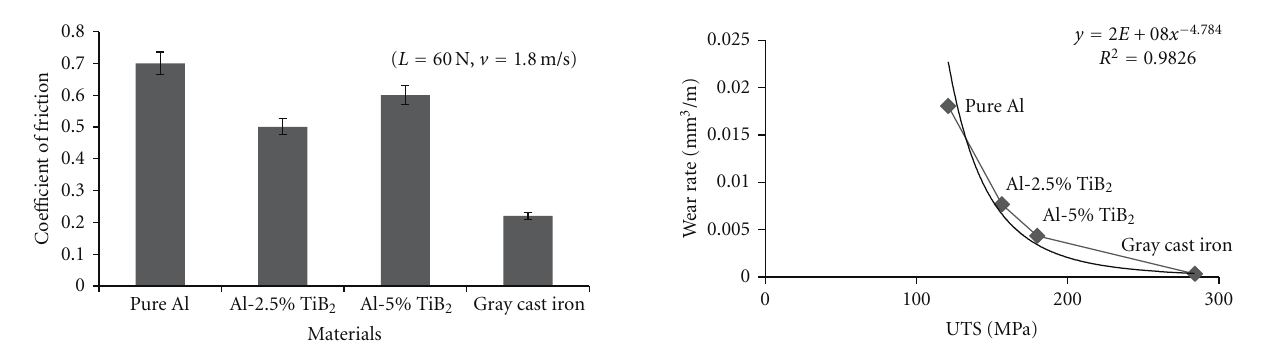
Figure 11: Coe ffi cient of friction variation of sliding pins made out of di ff erent materials.